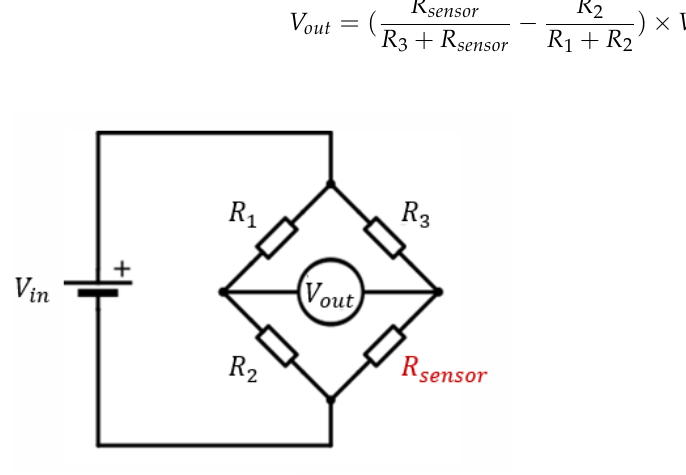
Figure 15. Wheatstone bridge circuit schematic.